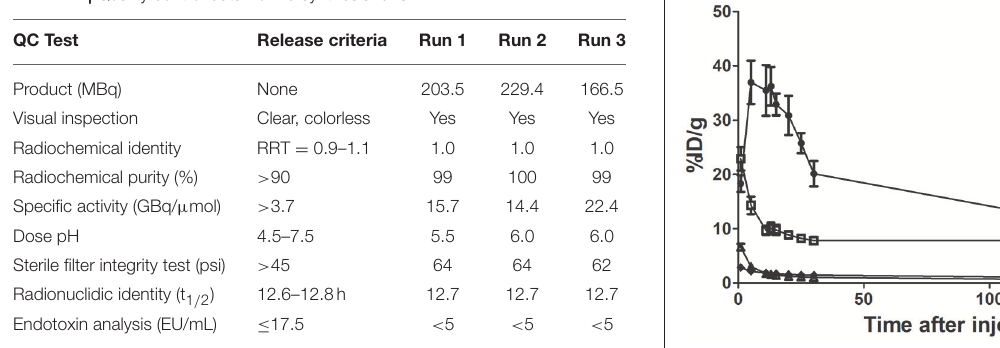
TABLE 1 | Quality control data from 3 synthesis runs.